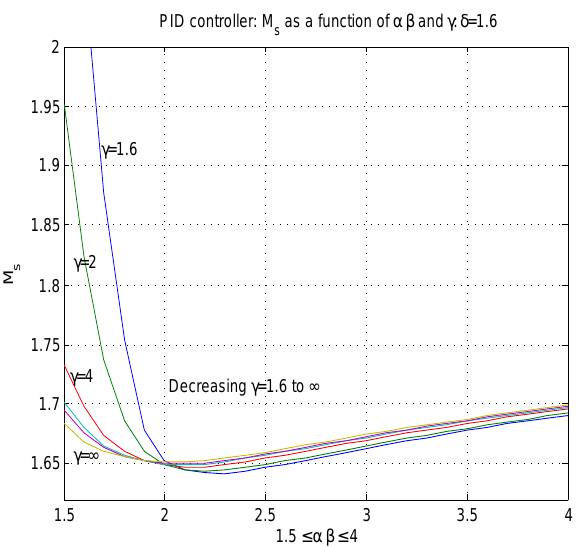
Figure 8: Illustration of sensitivity index M s as a func- tion of the tuning parameter ¯ c for varying in- tegral derivative ratio γ . PID controller tun- ing Alg. 2.1 and Eq. (27) with fixed relative delay margin δ = 1 . 6 for a DIPTD plant with K = 1 and τ = 1.